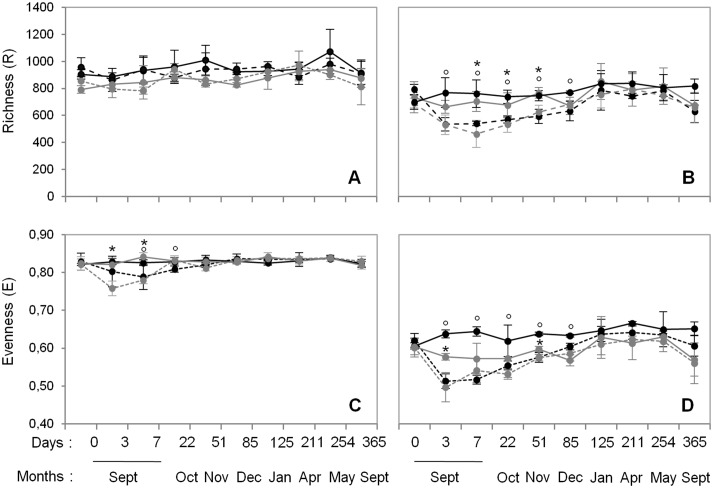
Dynamics of bacterial (A and C) and fungal (B and D) richness and evenness during the 12-month experiment in control (full line) and wheat-amended plots (dashed line) for each soil history: grassland (grey) and cropland (black).Error bars denote standard deviation of biological replicates (n = 3). Symbols in superscript indicate significant differences according to Fisher test (P<0.05) between control and corresponding wheat amended sub-plots for each grassland (stars) and cropland (circles) history.